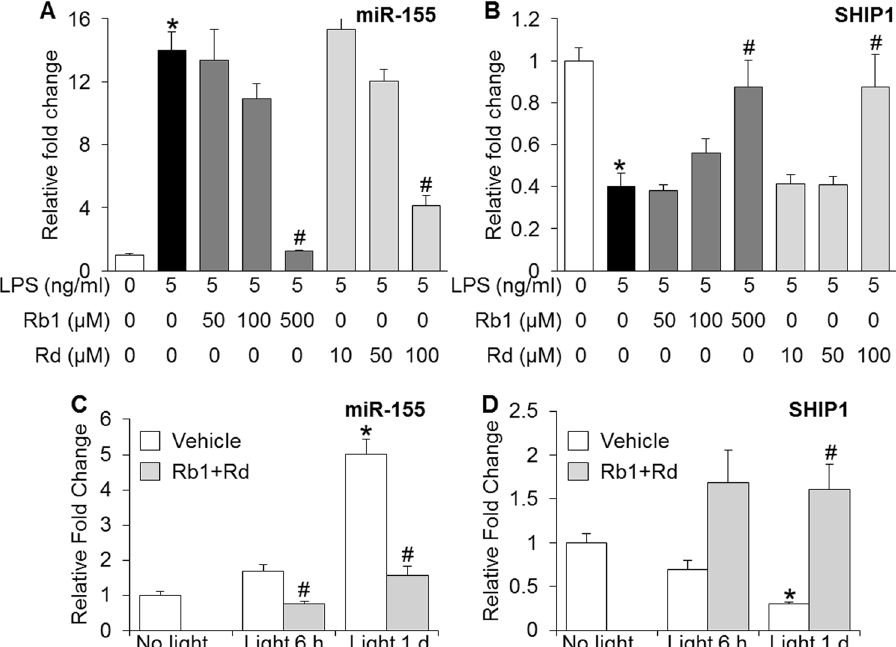
Figure 10. Altered expression of miR-155 and SHIP1 was implicated in the anti-inflammatory and retinal protective activities of Rb1 and Rd. A. RAW264.7 cells were first treated with Rb1 or Rd at the indicated concentrations for 30 min, followed by LPS stimulation delivered at 5 ng/ml for 6 h. Total RNA was isolated from harvested cells and real-time PCR analyses were performed to examine the expression of miR-155 ( A ) and its target gene SHIP1 ( B ) (n = 4–6 per group). Relative fold change was calculated against that detected in vehicle-treated cells without LPS stimulation. The data were expressed as the mean ± S.E.M. * Compared to that from vehicle-treated cells without LPS stimulation, p < 0.05; # compared to that from vehicle-treated cell with LPS stimulation, p < 0.05. Dark-adapted BALB/c mice were treated with saline vehicle (Vehicle) or combination of Rb1 (65 mg/kg bw) and Rd (22.5 mg/kg bw) (Rb + Rd), followed by bright light exposure. Retinas were collected 6 h and 1 d after illumination along with those from vehicle-treated mice unexposed to bright light (No light). Total RNA was extracted and reverse-transcribed. Real-time PCR was subsequently performed to analyze the retinal expression of miR-155 ( C ) and SHIP1 ( D ) (n = 4–6 per group). Relative fold change of miR-155 and SHIP1 was calculated against that detected in vehicle-treated mice unexposed to bright light. The data were expressed as the mean ± S.E.M. * Compared to that from No light, p < 0.05; # compared to that from Vehicle, p <